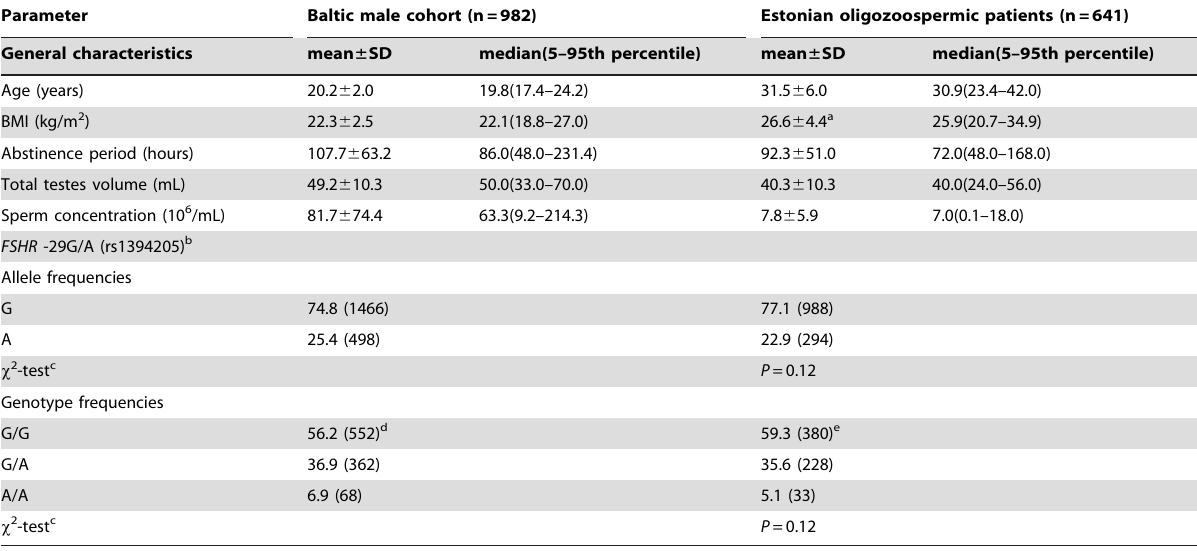
Table 1. General characteristics of the study